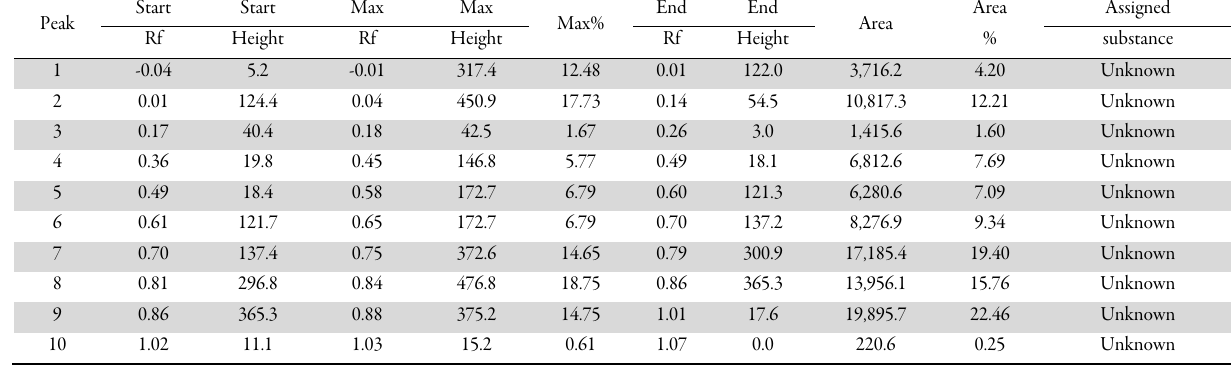
Table 10. HPTLC analysis of methanol reflux fruit extract